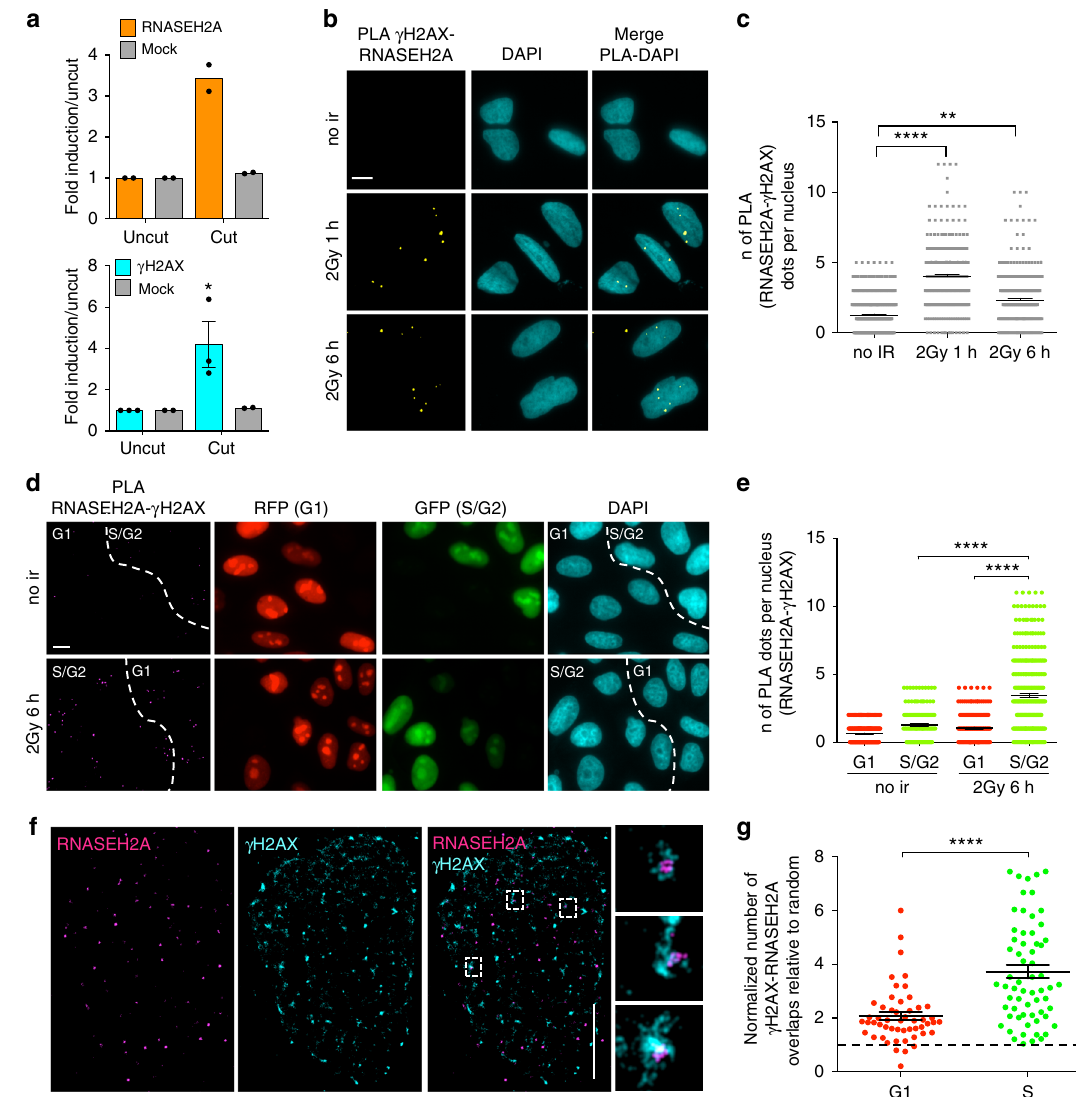
Fig. 5 RNase H2 is recruited to DSBs preferentially in the S/G2-phase of the cell cycle. a ChIP of RNASEH2A (top) and γ H2AX (bottom) at the AsiSI cut site in uncut or cut DIvA cells. The bar graph shows the fold induction in cut cells (6 h after AsiSI induction) compared to uncut. Error bars represent s.e.m. ( n ≥ 2 biological replicates). b Representative images of PLA between RNASEH2A and γ H2AX in not irradiated (no ir) or irradiated (2 Gy) U2OS cells. Scale bar: 10 μ m. c Dot plot shows the number of signals per nucleus of PLA between RNASEH2A and γ H2AX in not irradiated (no ir) or irradiated (2 Gy) U2OS cells. At least n = 200 cells were counted from four independent experiments. Lines represent mean ± s.e.m. d Representative images of PLA between RNASEH2A and γ H2AX in not irradiated (no ir) or irradiated (2 Gy) HeLa-FUCCI cells. Scale bar: 10 μ m. e Dot plot shows number of signals per nucleus of PLA between RNASEH2A and γ H2AX in not irradiated (no ir) or irradiated (2 Gy) HeLa-FUCCI cells. At least n = 170 cells were counted from three independent experiments. Lines represent mean ± s.e.m. f Representative pictures of super-resolution imaging analysis of γ H2AX (cyan) and RNASEH2A (magenta) colocalization in G1- or S-phase synchronized NCS-treated U2OS cells. Scale bar: 5 μ m. g Dot plot shows the normalized number of overlaps relative to random of γ H2AX and RNASEH2A signals in G1- or S-phase cells. At least n = 50 events were counted from three independent experiments. Lines represent mean ± s.e.m. ** P < 0.01, **** P < 0.0001 (two-tailed Student ’ s t test). Source data are provided as a Source Data fi